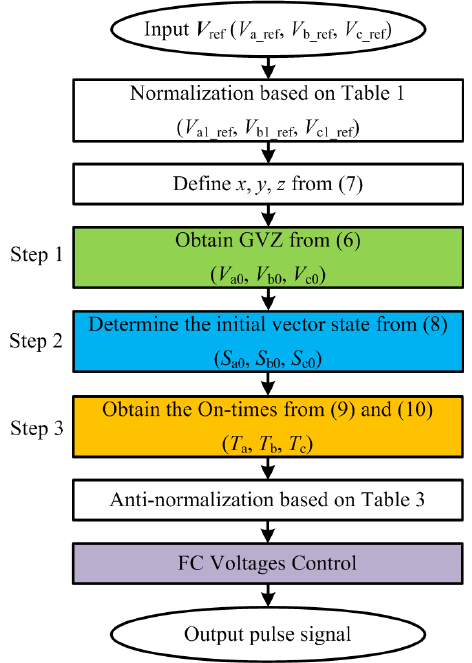
Figure 15. The modulation strategy of the four-level inverter.